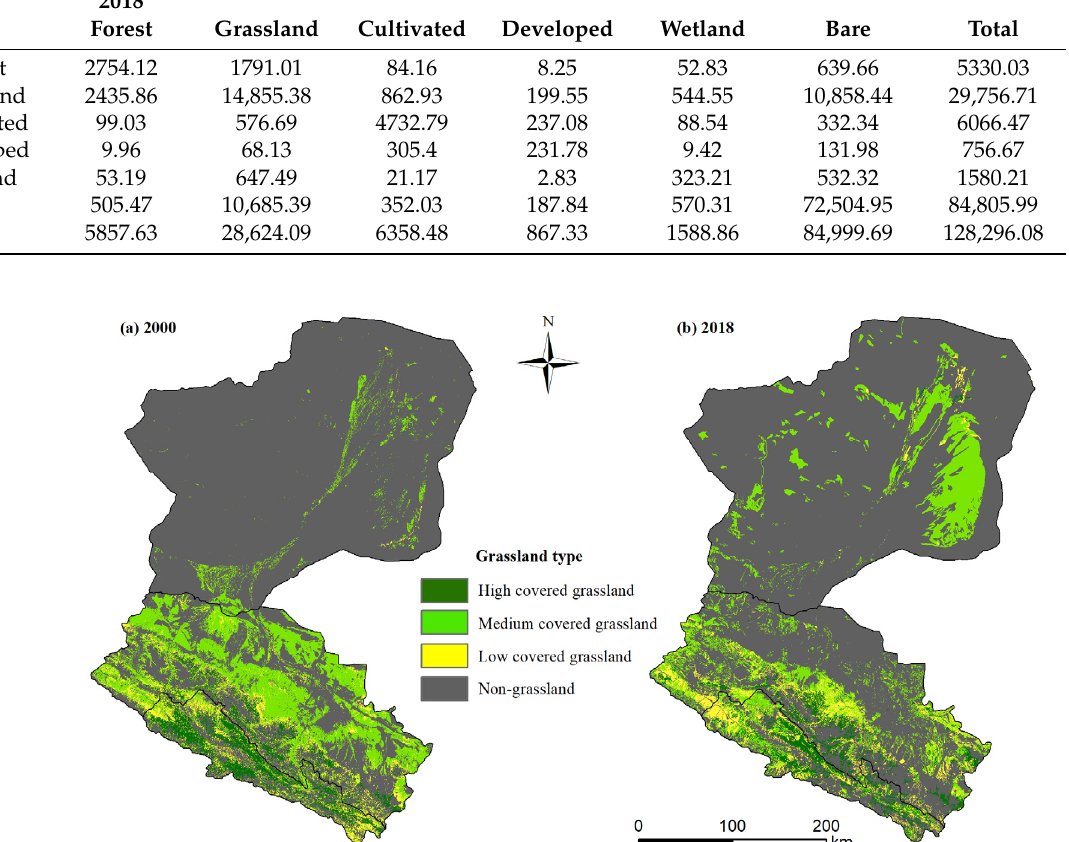
Table 1. Land-use/land-cover (LULC) transition matrix for HRB, 2000–2018 (units = km 2 ).